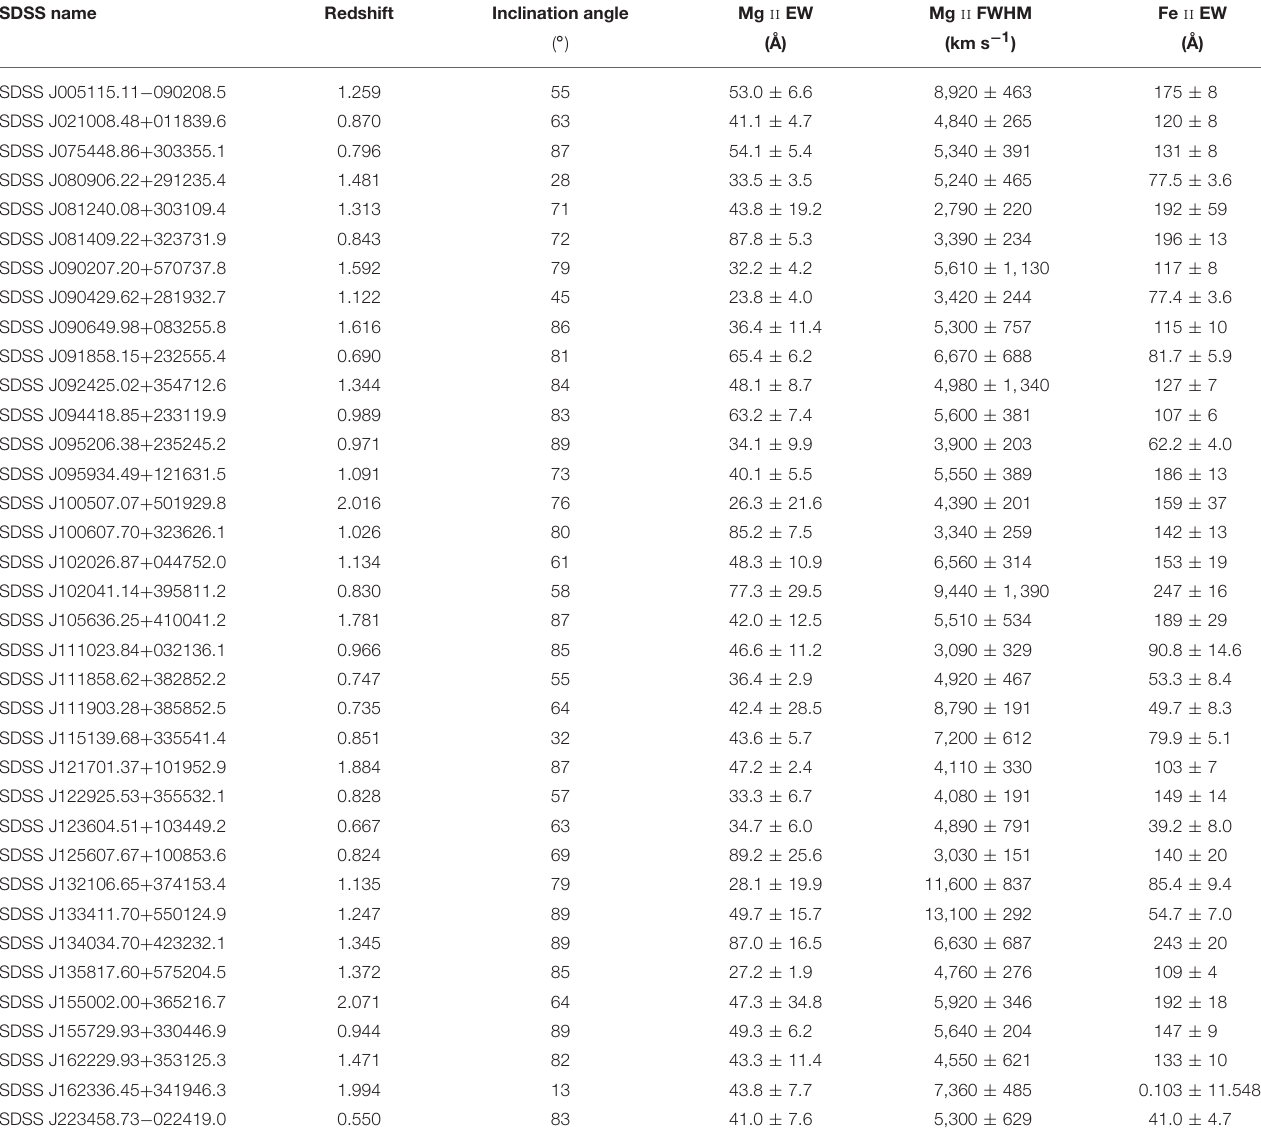
TABLE 1 | List of quasars used for Mg II